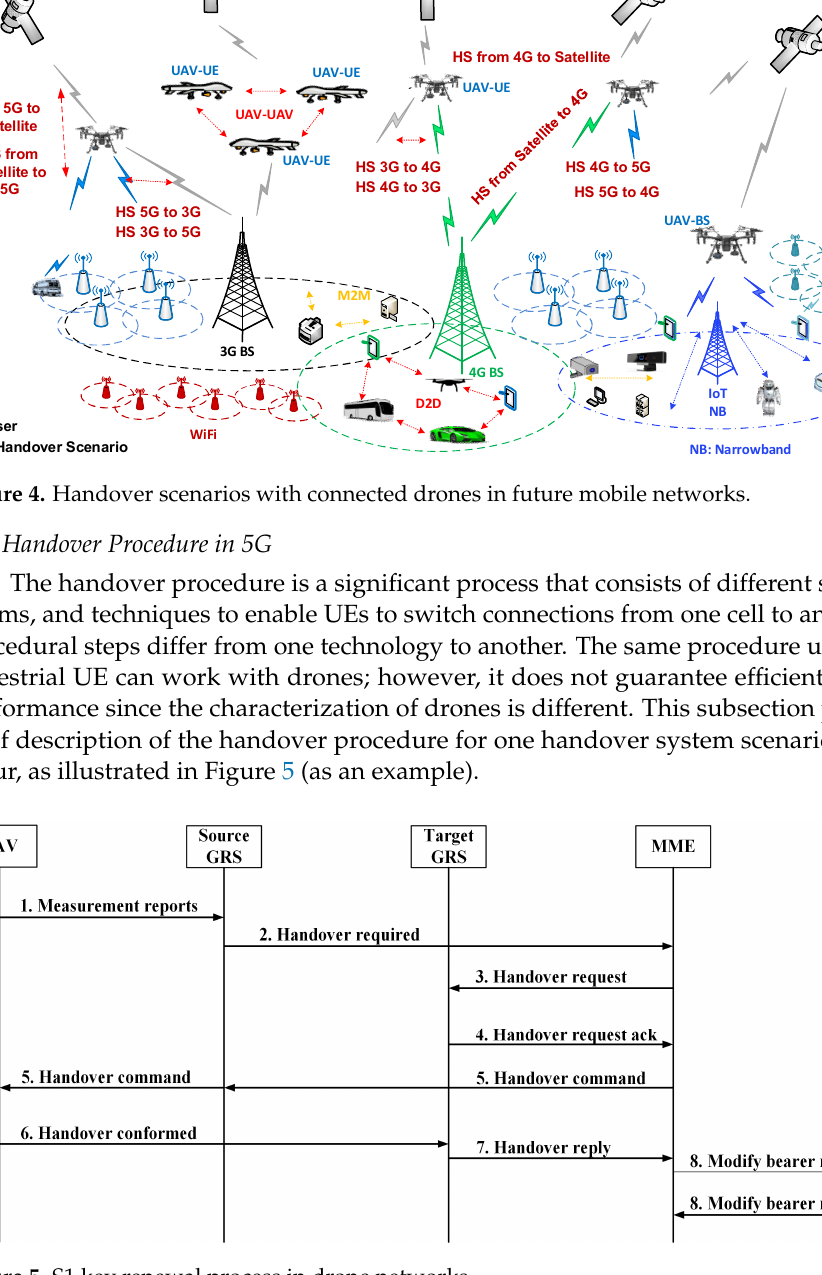
Figure 5. S1 key renewal process in drone